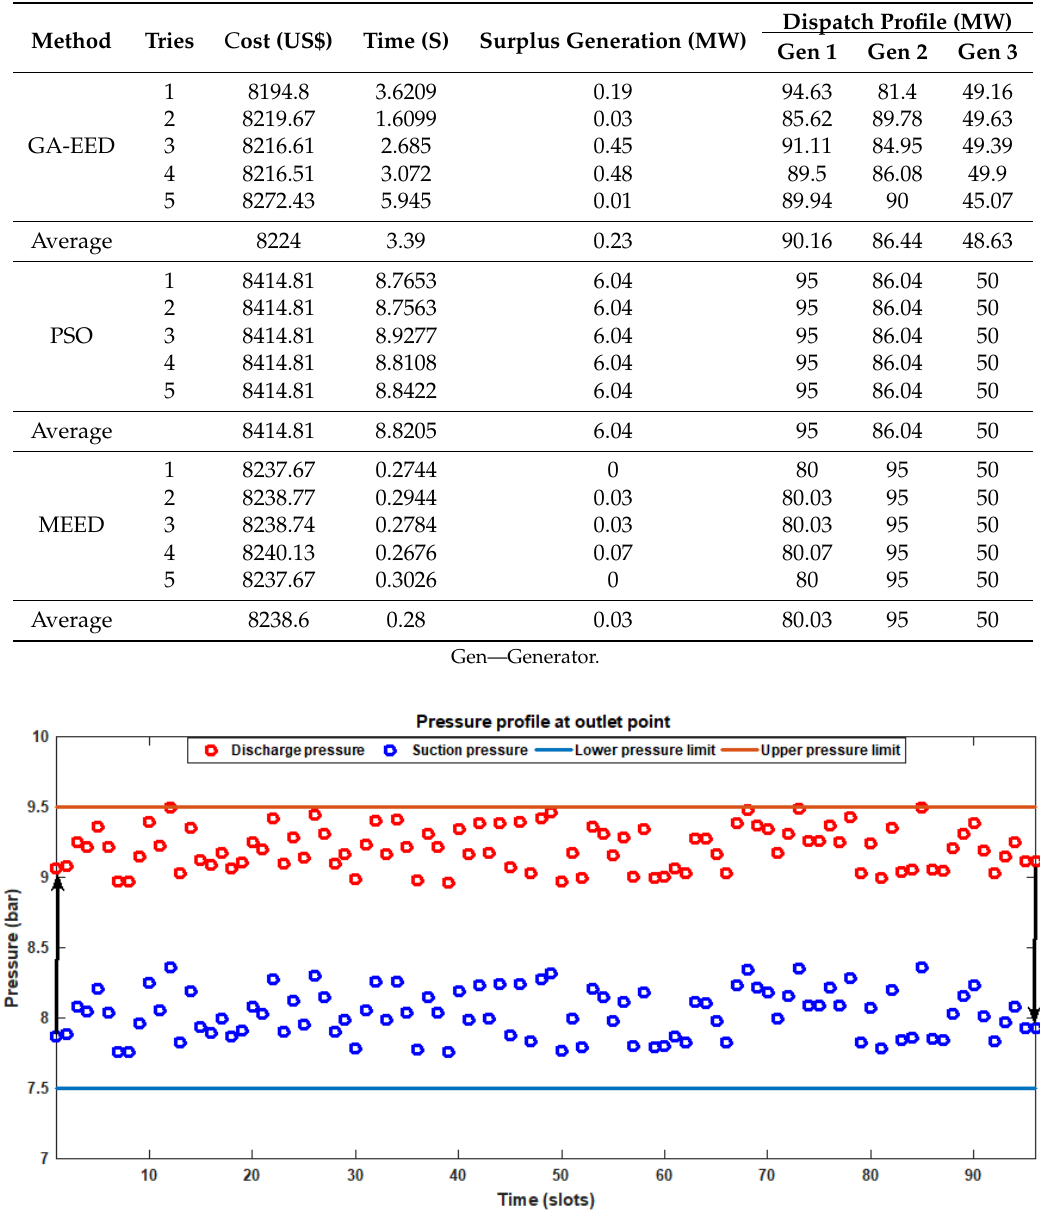
Table 5. GA-EED, MEED and PSO dispatch profile for 225 MW.